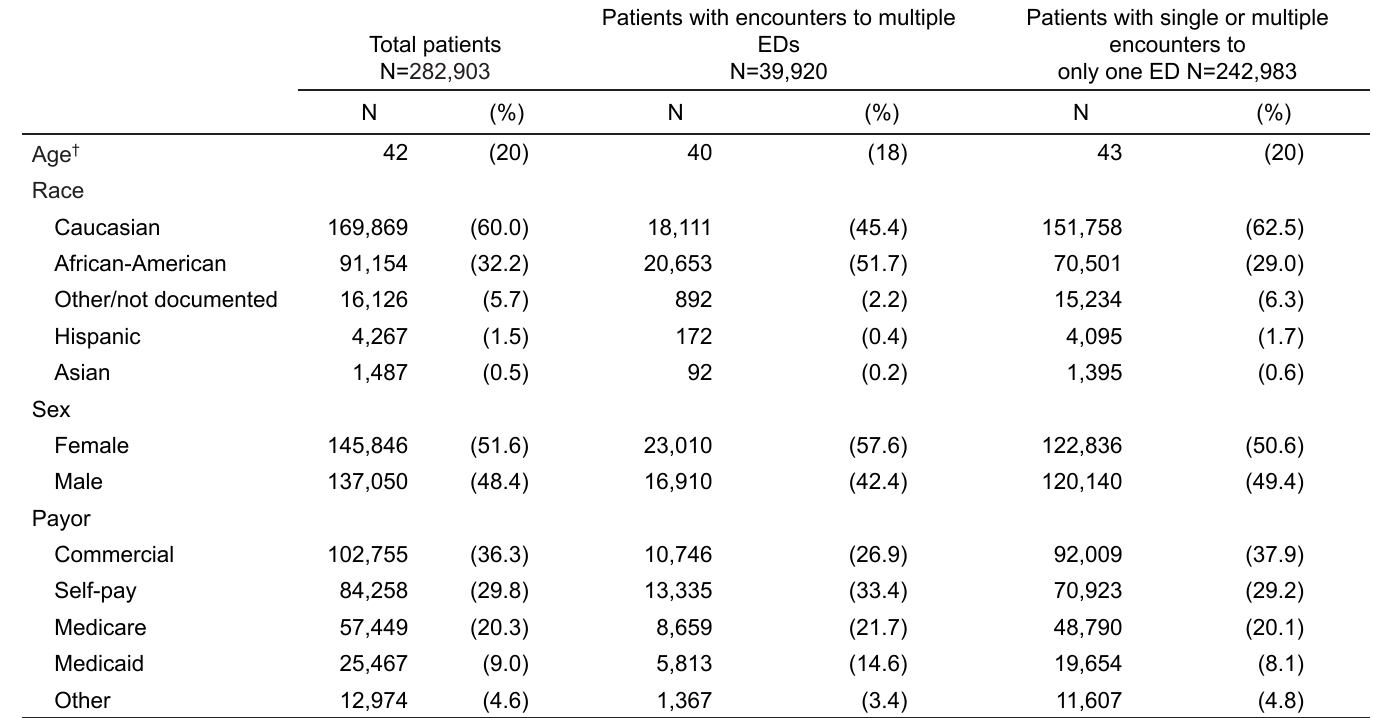
* Includes only first encounter to any ED during the study period; future encounters excluded to avoid patient duplication. † Presented as mean and (standard